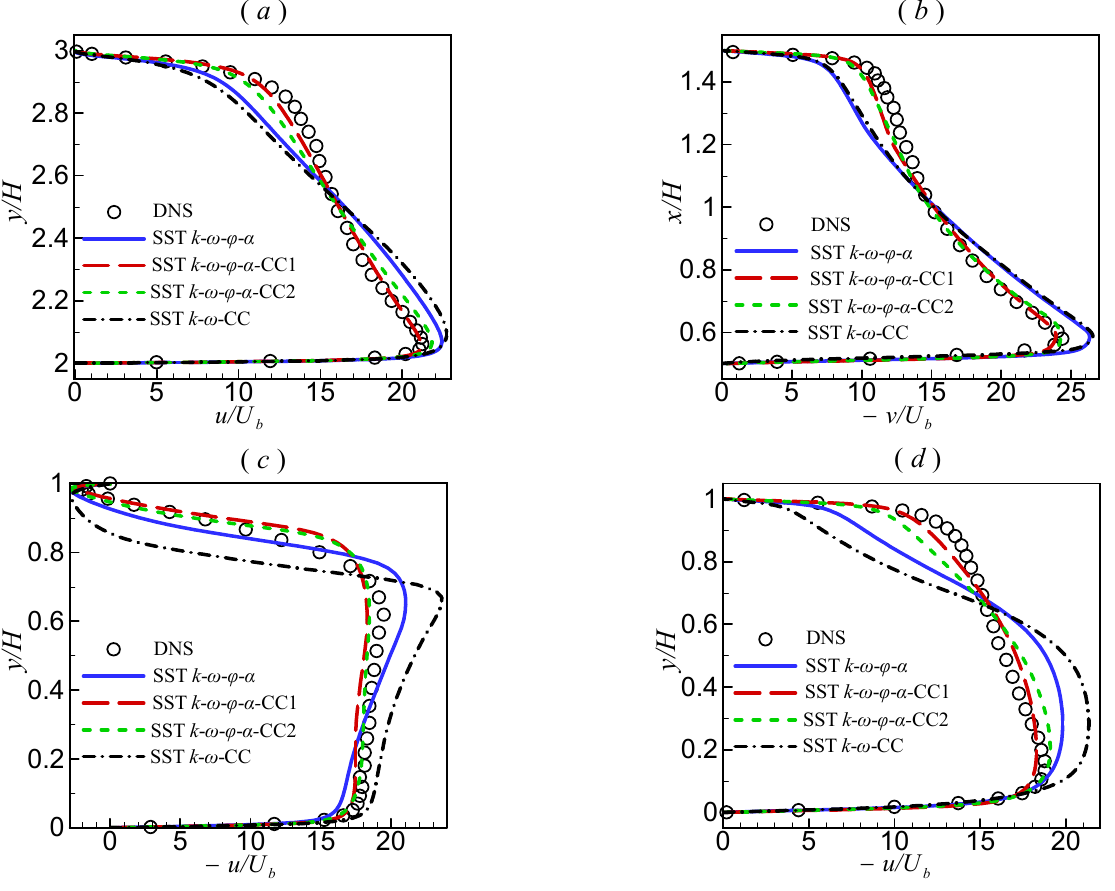
Figure 3. Comparison of velocity profiles along different transverse lines for the 2D infinite serpentine passage flow: ( a ) l 1 ; ( b ) l 2 ; ( c ) l 3 ; and ( d ) l 4 . Figure 4 shows the friction coefficient ( C f = 2 τ w / ) along the inner and outer walls near bend 1. To facilitate the analysis, an arc coordinate ( s ) was used, as shown in Figure 1. In the first half of the inner wall ( s / H < 1.5), the C f predicted by the four models were similar and agreed with the DNS results well. However, in the latter part ( s / H > 1.5), the C f predicted by the four models differed dramatically. The predictions of the STT k - ω - ϕ - α -CC1 and STT k - ω - ϕ - α -CC2 models were similar and agreed well with the DNS data. The original STT k - ω - ϕ - α model and the STT k - ω -CC model delayed the recovery of the C f significantly. For C f along the outer wall, the predictions of the four models displayed obvious differences, even in the first half of the wall. Therefore, the results obtained from the two proposed models were better.